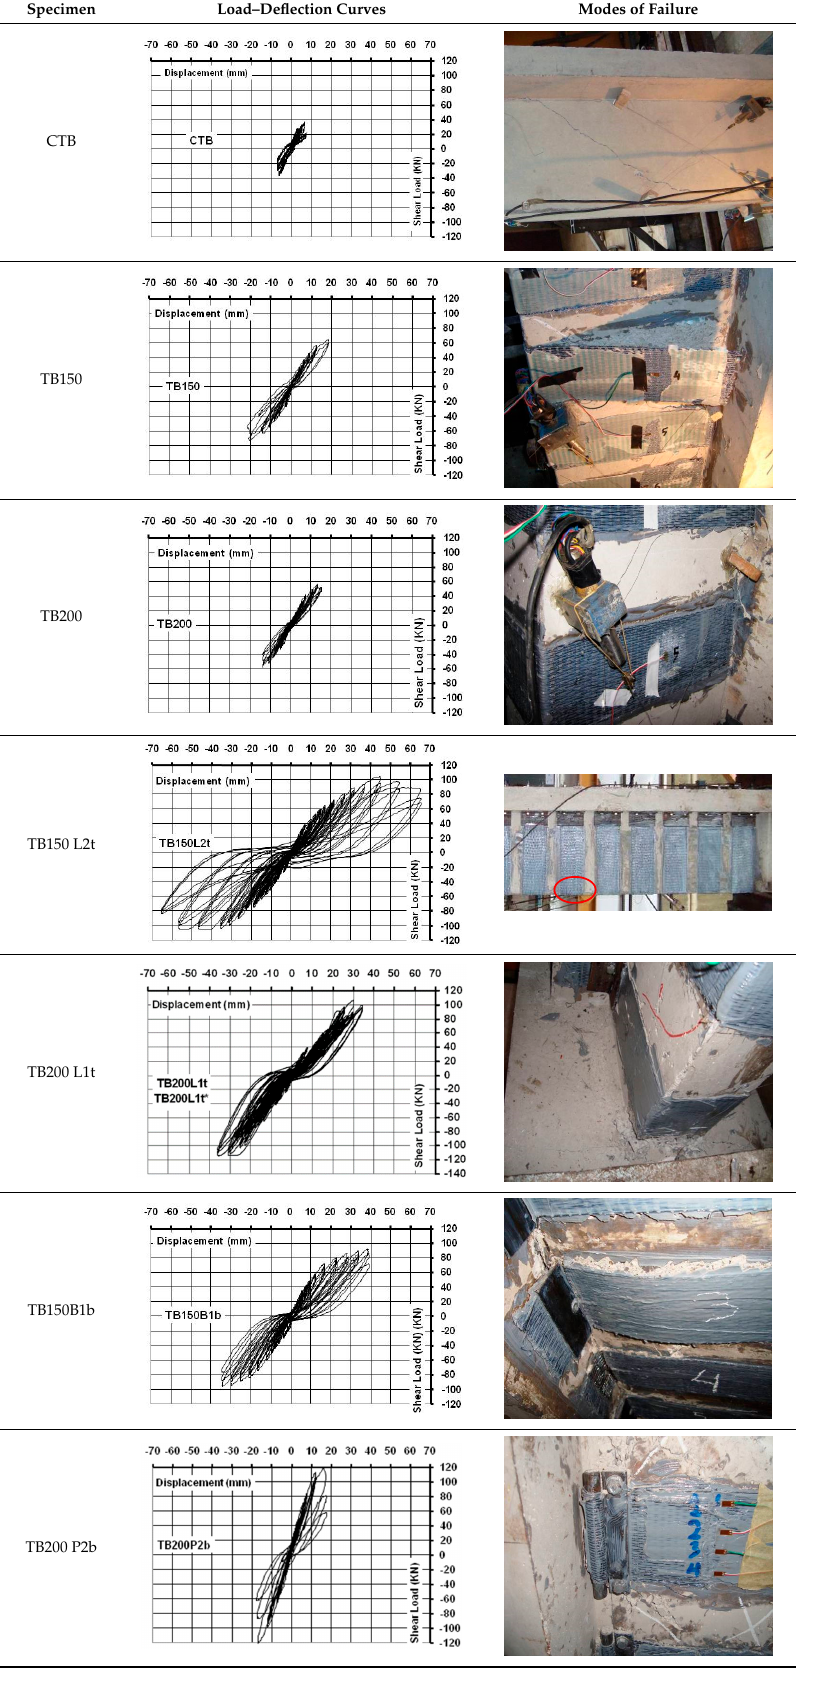
Table 3. Load–deflection curves together with modes of failure for each beam.